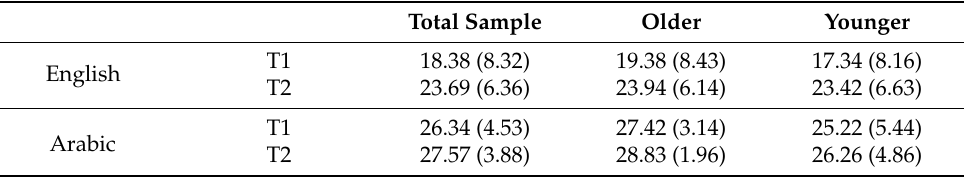
Table A3. Mean ( SD ) morphosyntactic accuracy score by the total sample and by the Younger and Older subgroups separately.